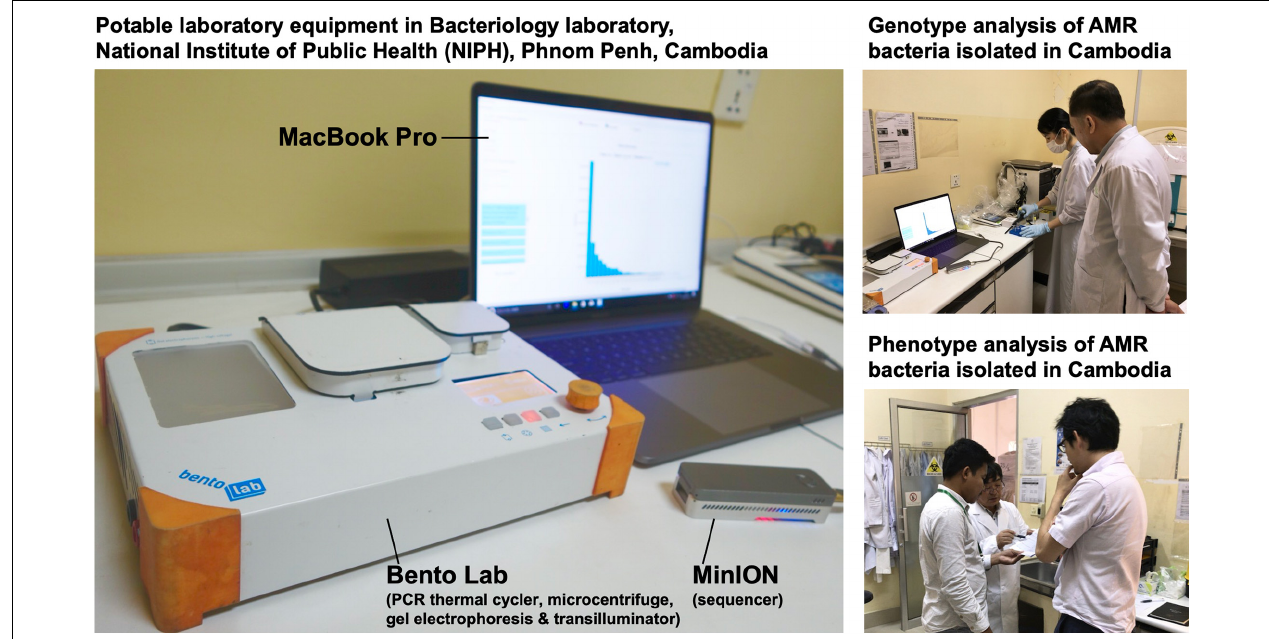
FIGURE 1 | On-site genomic epidemiological analysis of AMR bacteria in Cambodia. Bento Lab and MinION were used for genotype analysis and the carbapenem inactivation method (CIM) and double-disk diffusion tests (DDDTs) were used for phenotype analysis of AMR